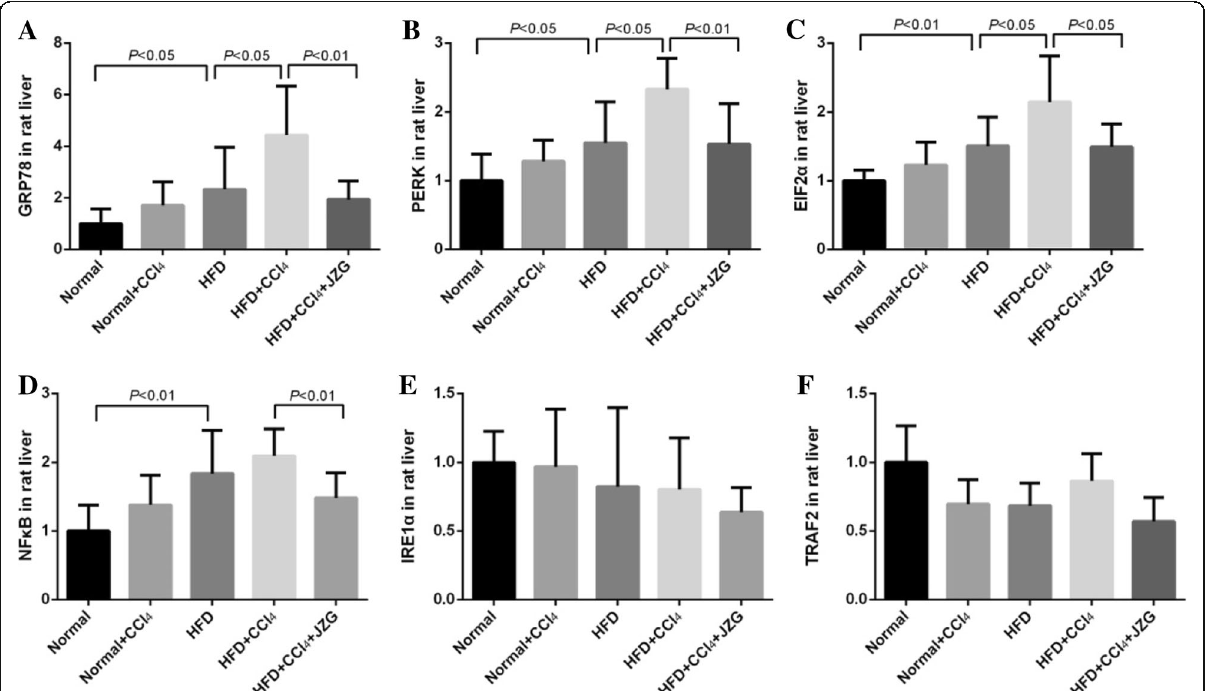
Fig. 6 Effect of JZG on the mRNA levels of ERS related genes: a GRP78, b PERK, c EIF2 α , d NF κ B, e IRE1 α , f TRAF2. The values represent mean ± SD. ( N = 8 per